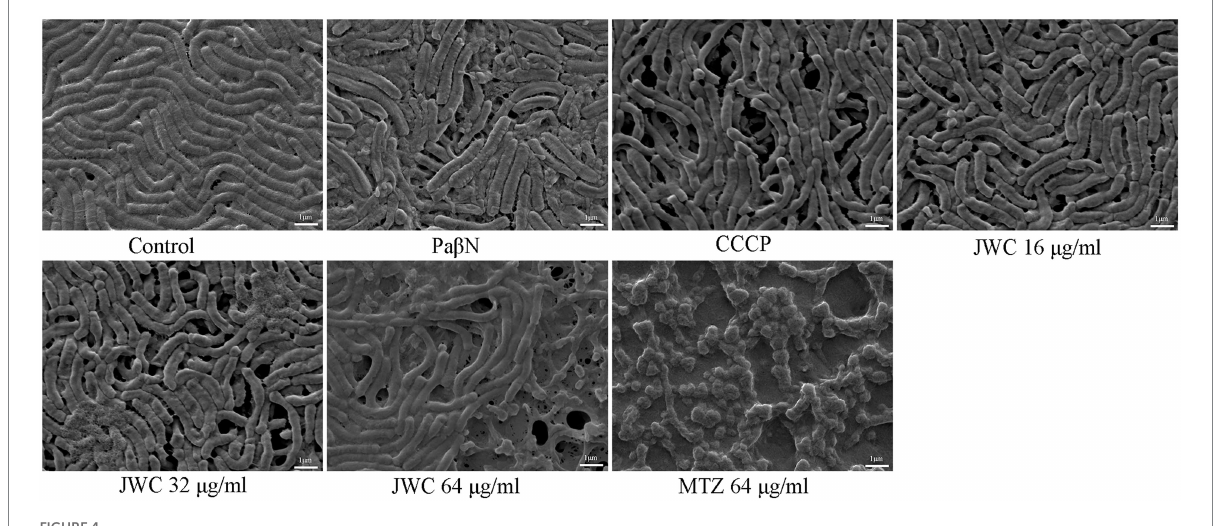
FIGURE 4 Effect of JWC and efflux pump inhibitors on the biofilm of H. pylori